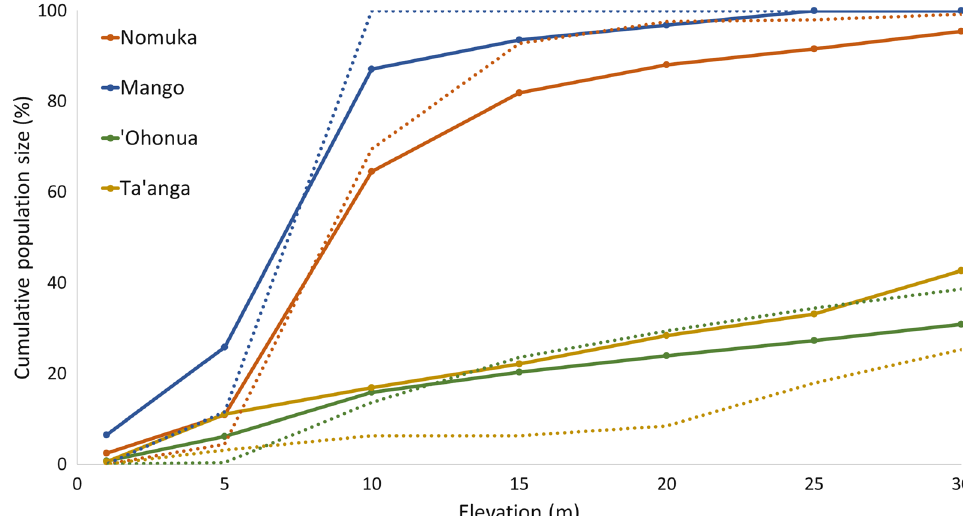
Fig. 5 Cumulative distribution of population and buildings in four selected villages damaged by the tsunami in 2022. Full lines: population distribution. Dotted lines: buildings distribution. Nomuka and Mango belong to the Ha’apai island group. ‘Ohonua and Ta’anga are in ‘Eua group